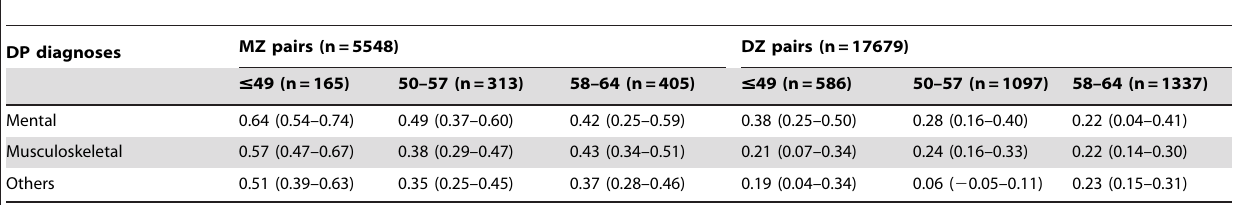
Table 3. Within-pair correlations (95% CI) for liability to disability pension (DP) for the main DP diagnostic groups, by zygosity pooled over the sexes.